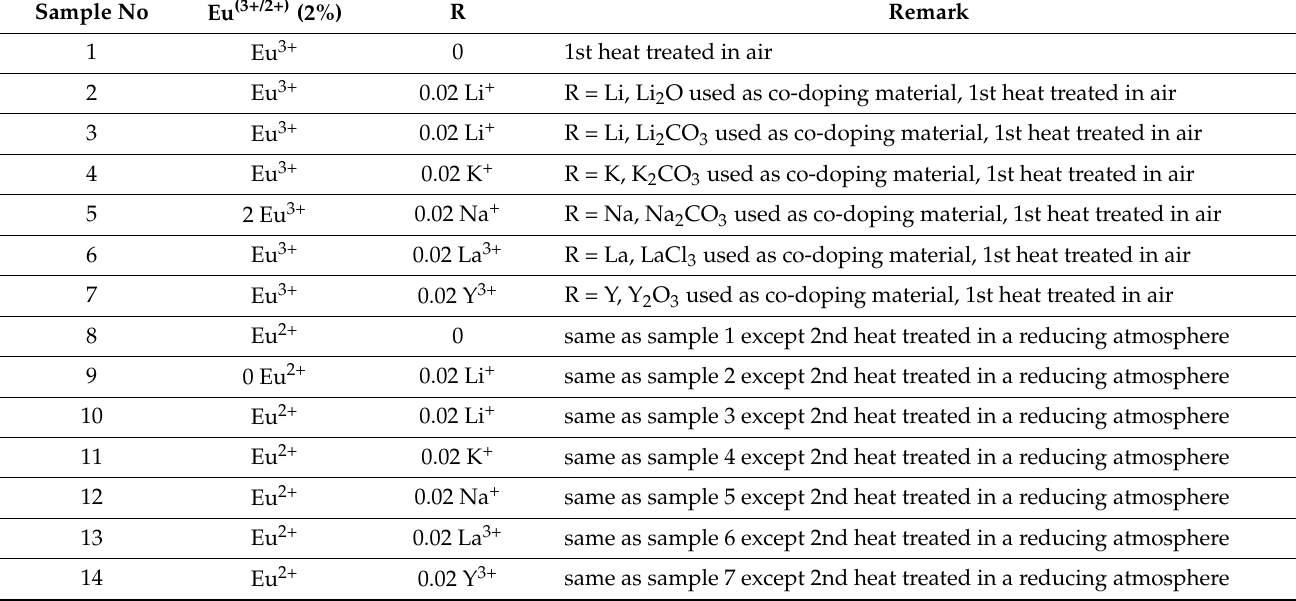
Table 1. Studied